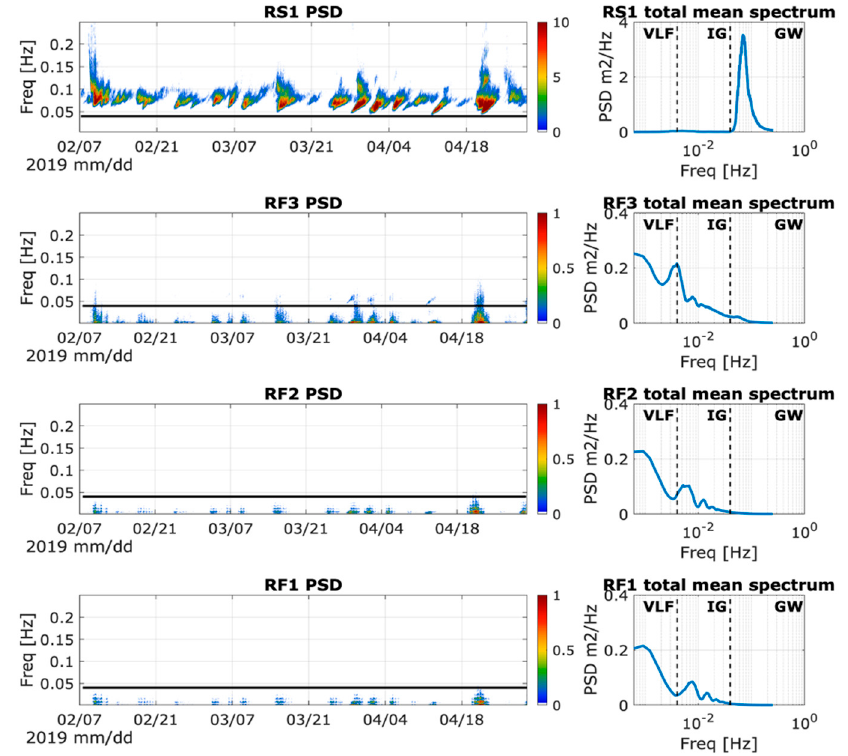
Figure 5. Spectral wave characteristics observed along the instrumental transect presented Figure 4b. The plots are organized in the shoreward direction from the top to the bottom (reef slope RS1 station on the top, and reef flat station RF1 closest to the shore on the bottom). The left panels show the temporal variation of the wave spectrum recorded at each station from February to April 2019. The black solid line indicates the frequency cut at 0.04 Hz between the gravity frequency band (GW) and the infragravity (IG) frequency band. The right panels show the mean power spectral density for each station averaged over the whole period, with the frequencies band GW, IG and VLF (for very low frequency) indicated.